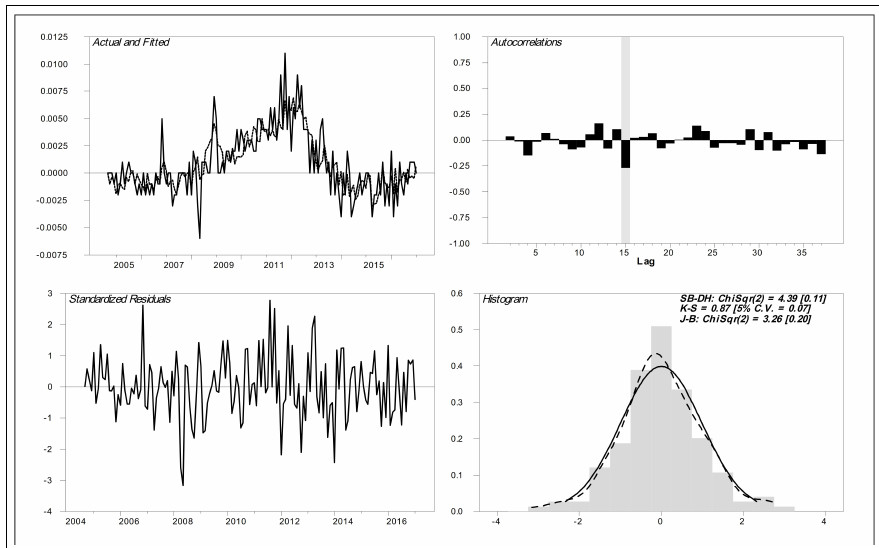
Figure 3: Graphs of actual and fitted change in the Greek unemployment rate (upper left hand side panel), the standardized residuals (lower left hand side panel), the residual autocorrelogram (upper right hand side panel), and the residual histogram compared with the normal